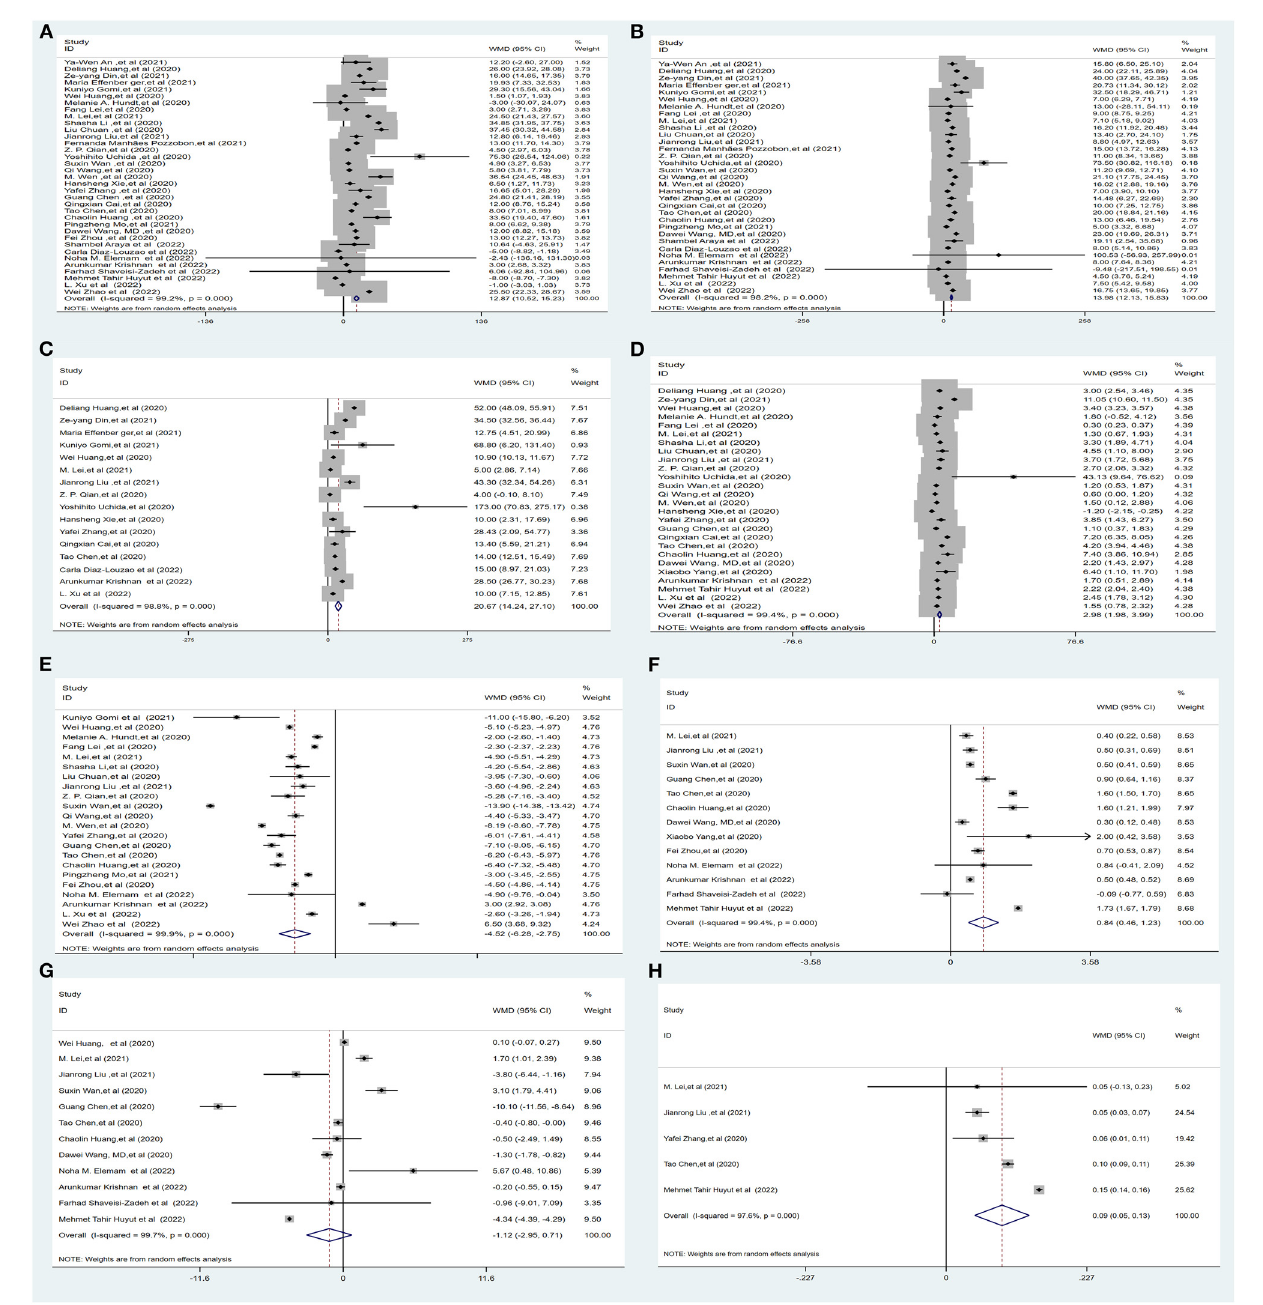
FIGURE3 Forest plot showing the mean serum weight levels of liver chemistries between severe and non-severe patients with COVID-19. (A) Serum ALT levels. (B) Serum AST levels. (C) Serum GGT levels. (D) Serum TBIL levels. (E) Serum ALB levels. (F) Serum PT levels. (G) Serum APTT levels. (H) INR. ALB, albumin; PT, prothrombin time; APTT, activated partial thromboplastin time; INR, international normalized